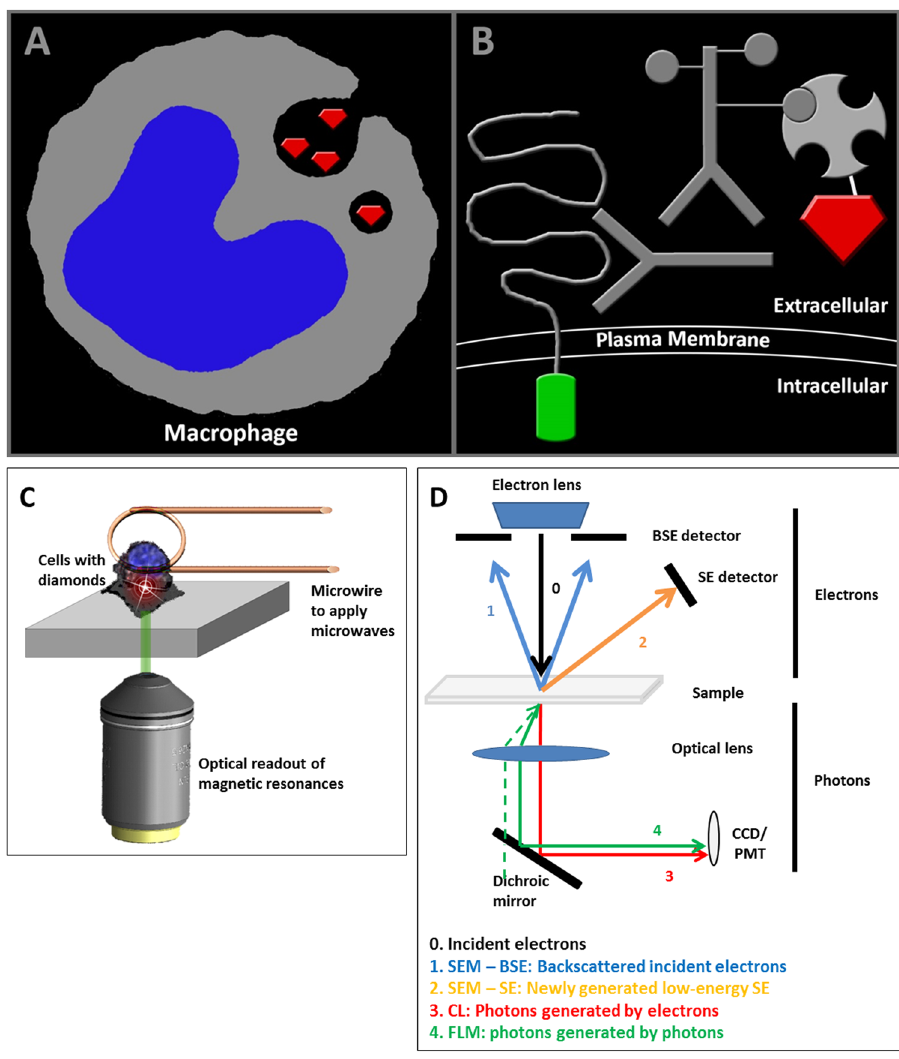
Figure 1. FND applications in this study. ( a ) Representation of FND40 uptake by macrophages. The diamond particles are phagocytosed by the macrophages and are transported in intracellular vesicles. ( b ) Immunolabeling approach: (1) the extracellular domain of EpCAM, with an intracellular GFP domain, is targeted by a monoclonal antibody (MOC-31); (2) biotinylated rabbit anti mouse IgG is used as a linker for labeling with (3) streptavidin-conjugated FND70 particles. ( c ) Schematic overview of the sample area of a diamond magnetometer for intracellular sensing. The cells, which contain diamond nanoparticles, are in a glass bottom petri dish. A microwire in close proximity is used to excite in the microwave regime. Simultaneously, fluorescence is collected through a microscope objective and a subsequent confocal microscope. ( d ) Schematic overview of integrated light and scanning EM and cathodoluminescence. (0) Primary incident electrons generate (1) backscattered electrons (BSE) and (2) secondary electrons (SE) which can be imaged in a SEM with the respective detectors. Also photons can be generated upon electron beam excitation called (3) cathodoluminescence (CL). Via an optical lens, these photons can be detected with for example a CCD camera or photo multiplier tube (PMT). Furthermore, with an integrated light and electron microscope (4) regular fluorescence imaging can be performed with photon